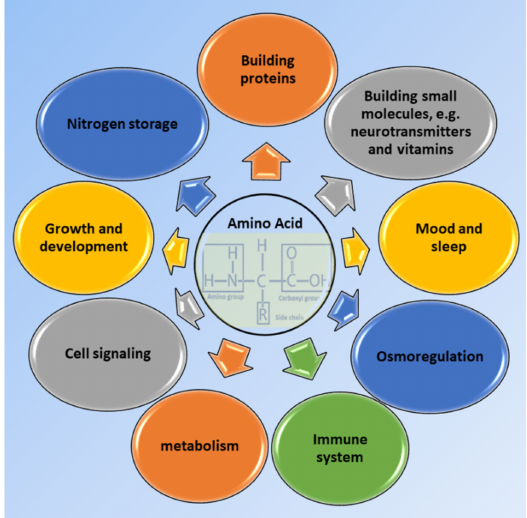
Figure 1. Some crucial roles of amino acids affecting our body functions.